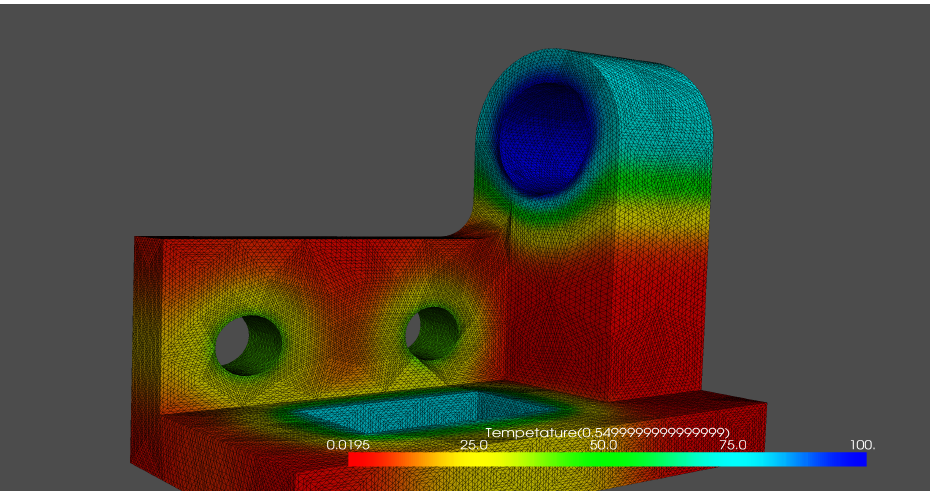
Figure 13. Temperature contour of a function space of order 3 at t = 0.55